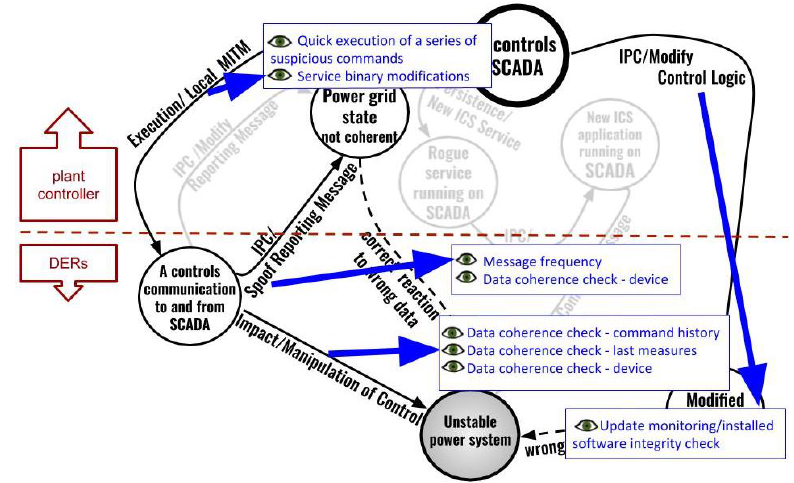
Figure 3. Example of mapping security analytics to